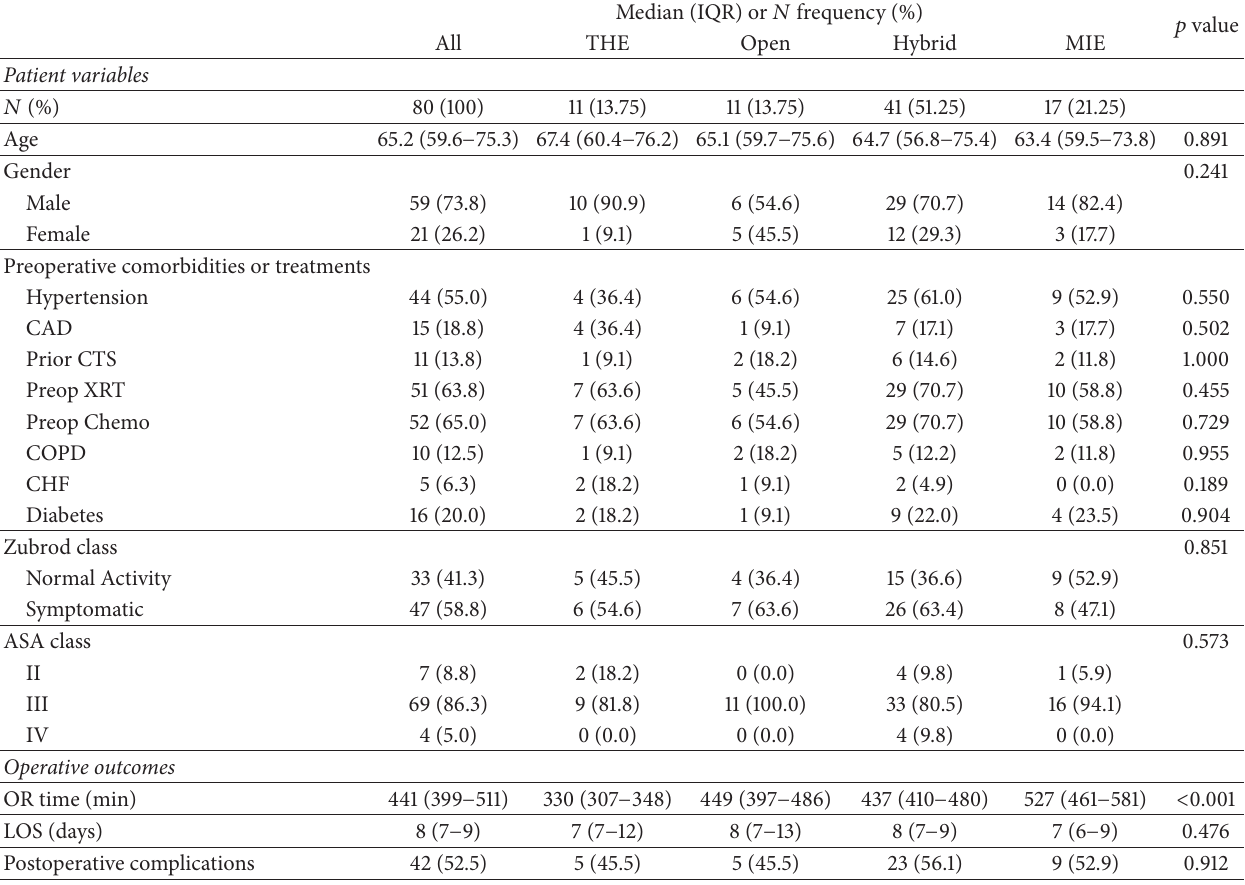
Table 1: Overview of study